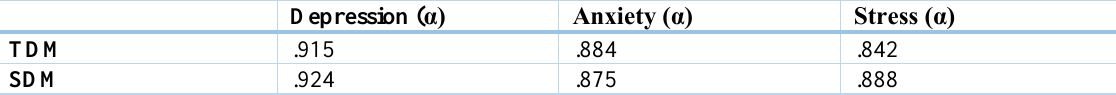
Cronbach Alpha Coefficients of the Subscales of the DASS-21 Depression (α) Anxiety (α) Stress